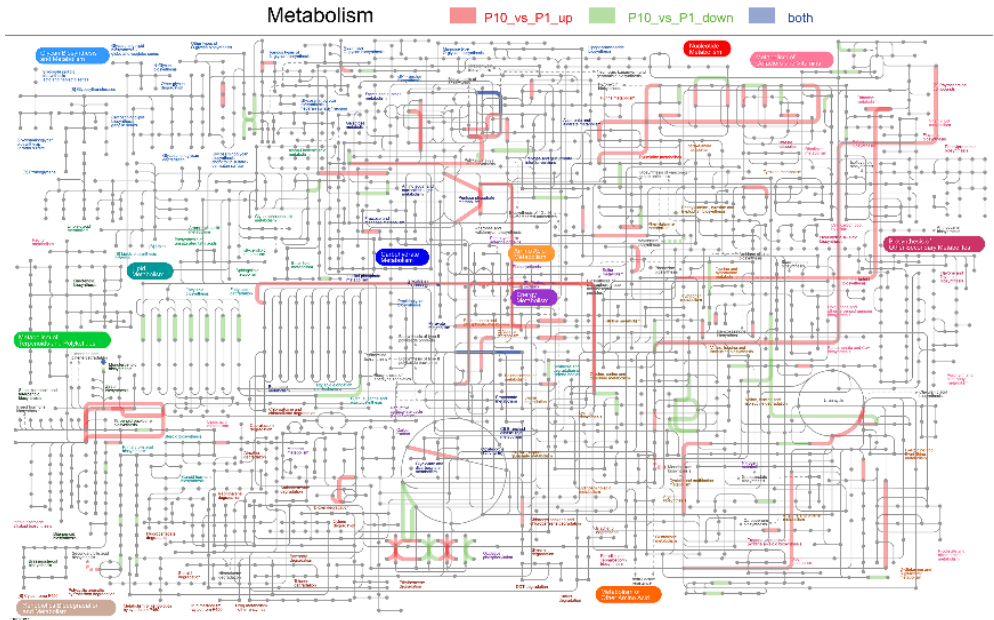
Figure 9. Integrated pathways of the metabolic processes in the DEPs. Pathways labelled with red lines indicated the up-regulated DEPs, green lines indicated down-regulated DEPs, and gray lines indicated that both the up- and down-regulated DEPs were included in it.